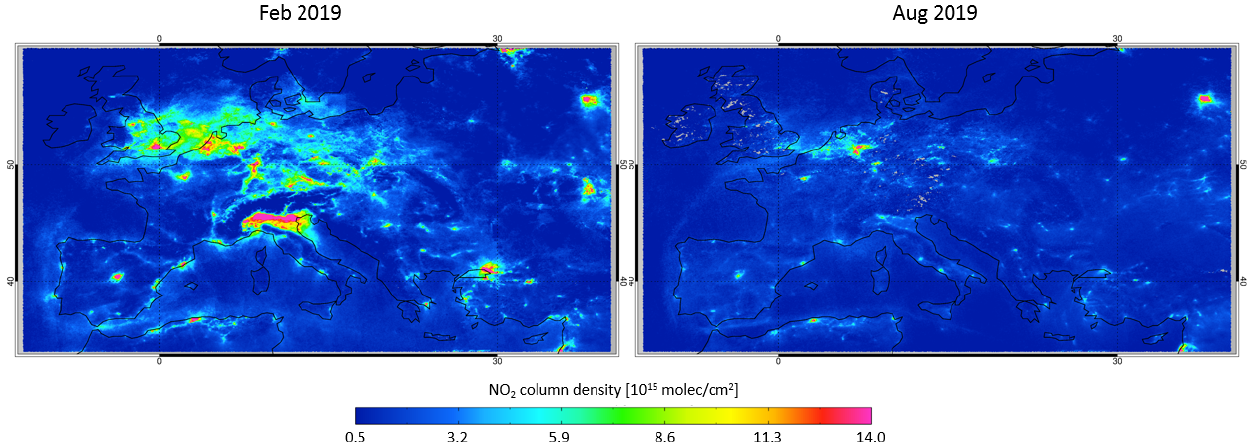
Figure 18. Tropospheric NO 2 columns from the improved algorithm over Europe in February and August 2019. Only measurements with a cloud radiance fraction less than 0.5 are